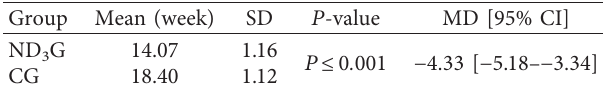
Table 2: Mean treatment time for mandibular anterior teeth alignment.